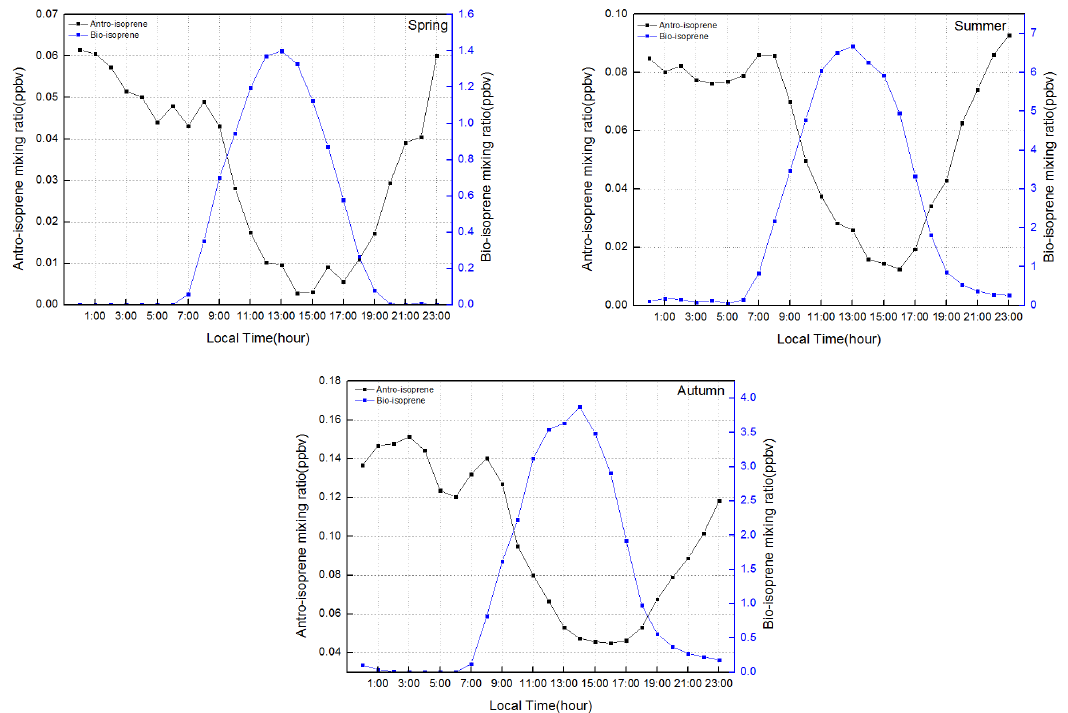
Figure 6. Diurnal patterns of the estimated anthropogenic and biogenic isoprene during spring, summer, and autumn at GPACS.